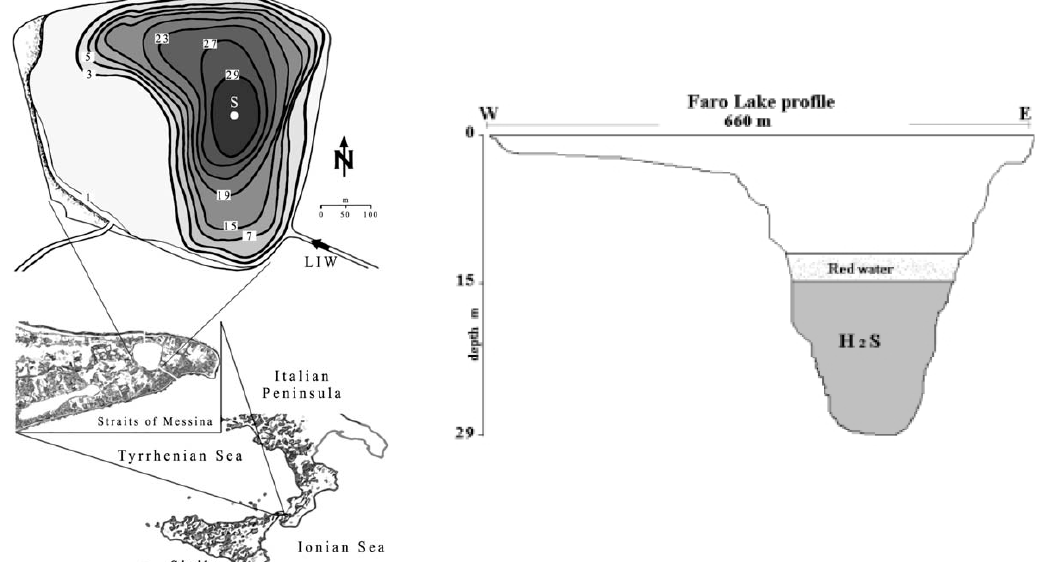
Figure 1. Location map and bathymetric chart of Lake Faro indicating the sampling site (S). Arrows show water inflow and outflow when the channels are both open and the Levantine Intermediate Waters (LIW) enter the lake [23,25]; modified.